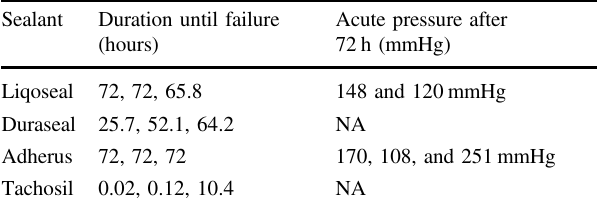
Table 3 Spinal resistance test results per sealant ( N = 3) Sealant Duration until failure